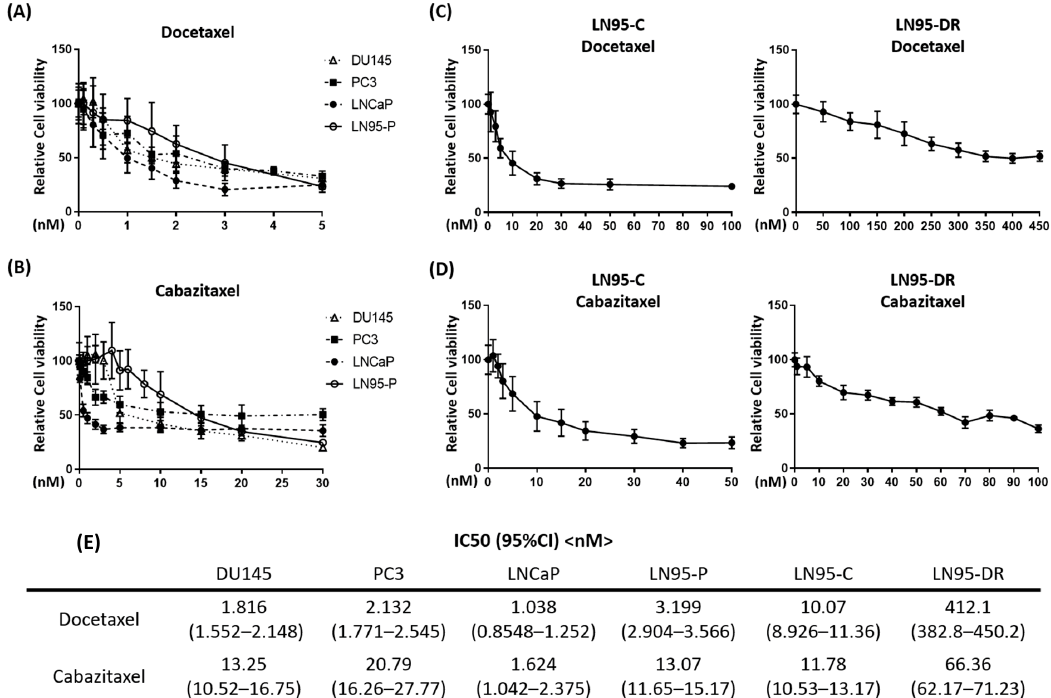
Figure 1. LN95-DR shows cross-resistance to cabazitaxel. Dose responses for docetaxel ( A ) and cabazitaxel ( B ) on the viability of prostate cancer cell lines (DU145, PC3, LNCaP, and LN95-P) assessed by the MTT assay; Dose responses for docetaxel ( C ) or cabazitaxel ( D ) on the viability of LN95-C and LN95-DR after 72 h; ( E ) A table showing IC50 values and 95% confidence intervals for docetaxel and cabazitaxel on prostate cancer cell lines. LN95-P: parental LNCaP95; LN95-C: time-matched parental LNCaP95 cells treated with DMSO as a vehicle control; LN95-DR: LNCaP95 with acquired resistance to docetaxel.